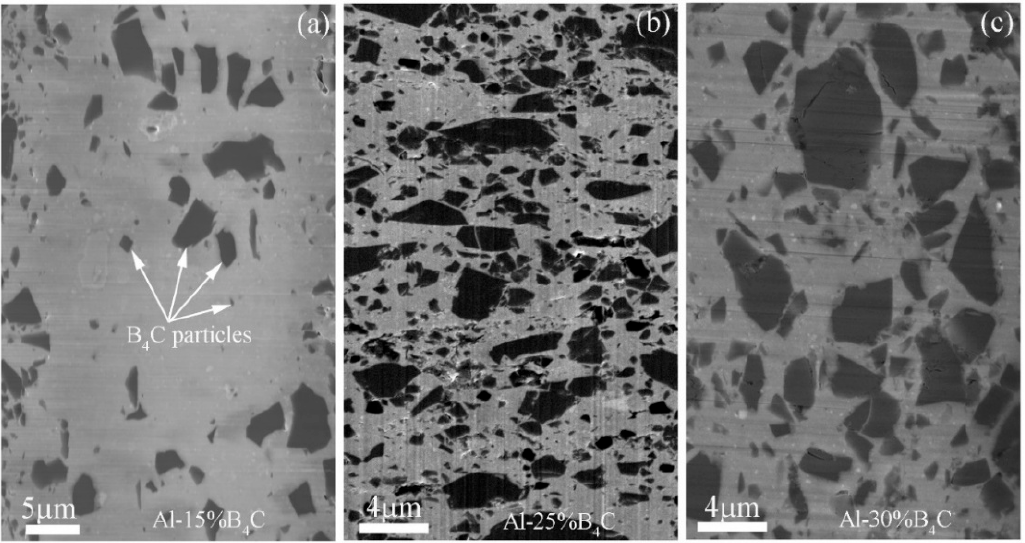
Figure 2. SEM images showing the microstructures and morphology of ( a ) Al-15%B 4 C; ( b ) Al-25%B 4 C and ( c ) Al-30%B 4 C MMCs.